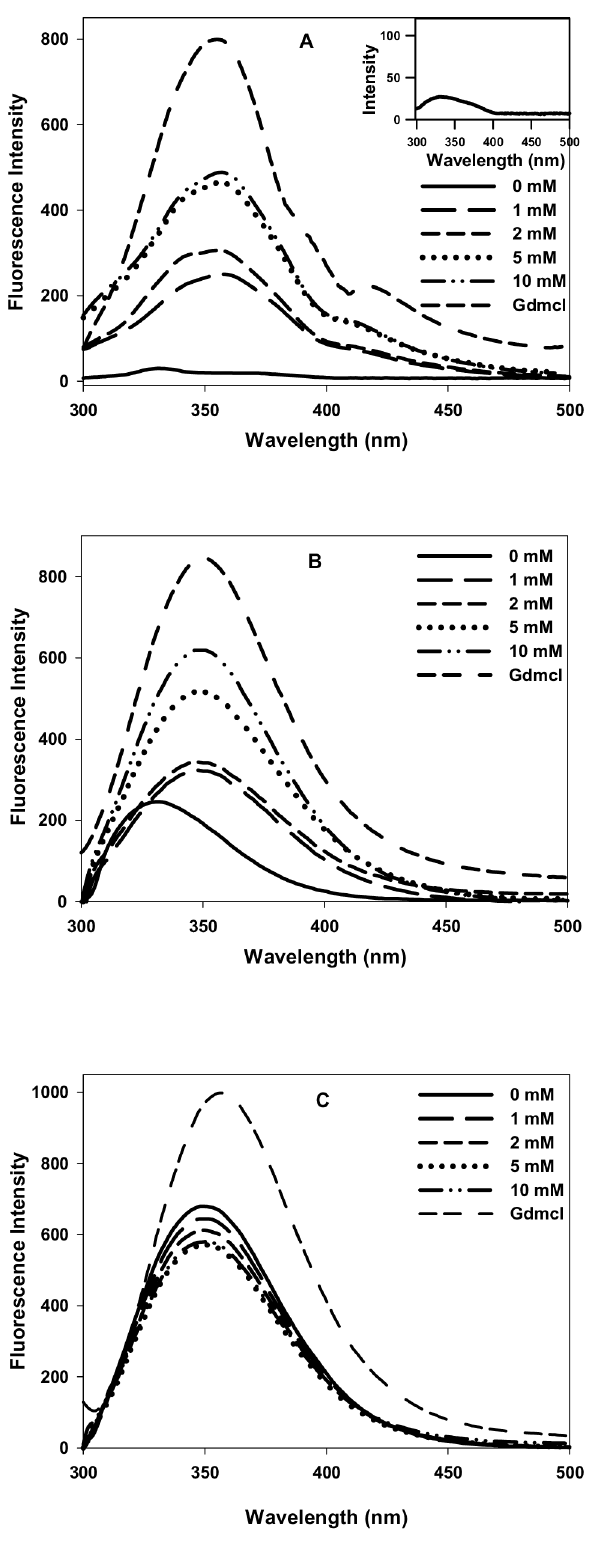
Figure 4. Effect of homocysteine thiolactone (HTL) on the intrinsic fluorescence of the native state of proteins. Intrinsic fluorescence spectra of (A) cyt-c (at 18 hours), (B) a -LA (at 4 hours) and (C) lysozyme (at 24 hours) modified with different concentrations of HTL. Unfolded state control (7.0 M GdmCl) have also been shown